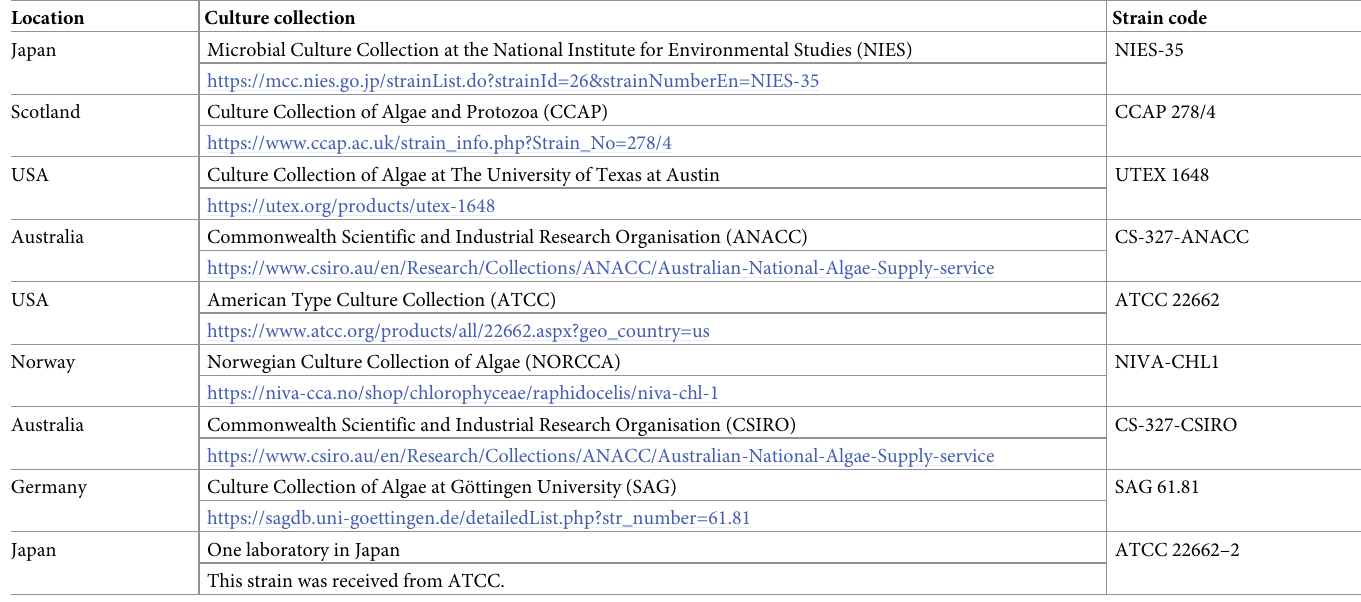
Table 1. Raphidocelis subcapitata strains used in this study.